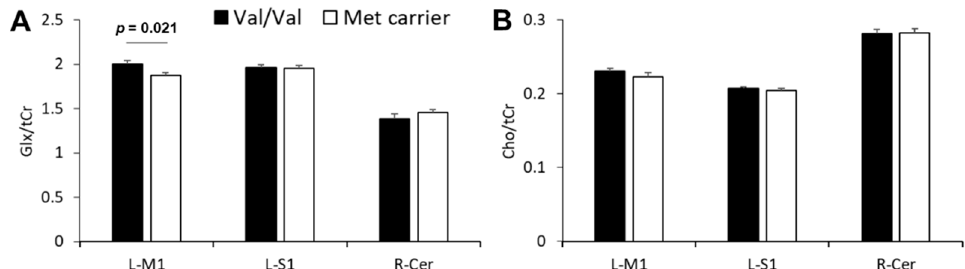
Table 3. Mean neurometabolite concentrations in M1, S1, and the cerebellum. Figure 4. Effect of BDNF genotype on Glx and Cho levels. ( A ) Average Glx/tCr levels for the left M1 (L-M1), left S1 (L-S1), and right cerebellum (R-Cer) regions by BDNF genotypes, the Val/Val group or Met group. ( B ) Average Cho/tCr levels for each region by BDNF genotypes. The Met group included both the Val/Met ( n = 11) and Met/Met ( n = 5) carriers. Abbreviations: Glx, glutamate plus glutamine; tCr, total creatinine; L-M1, left primary motor cortex; L-S1, left primary somatosensory cortex; R-Cer, right cerebellum; Cho, choline.